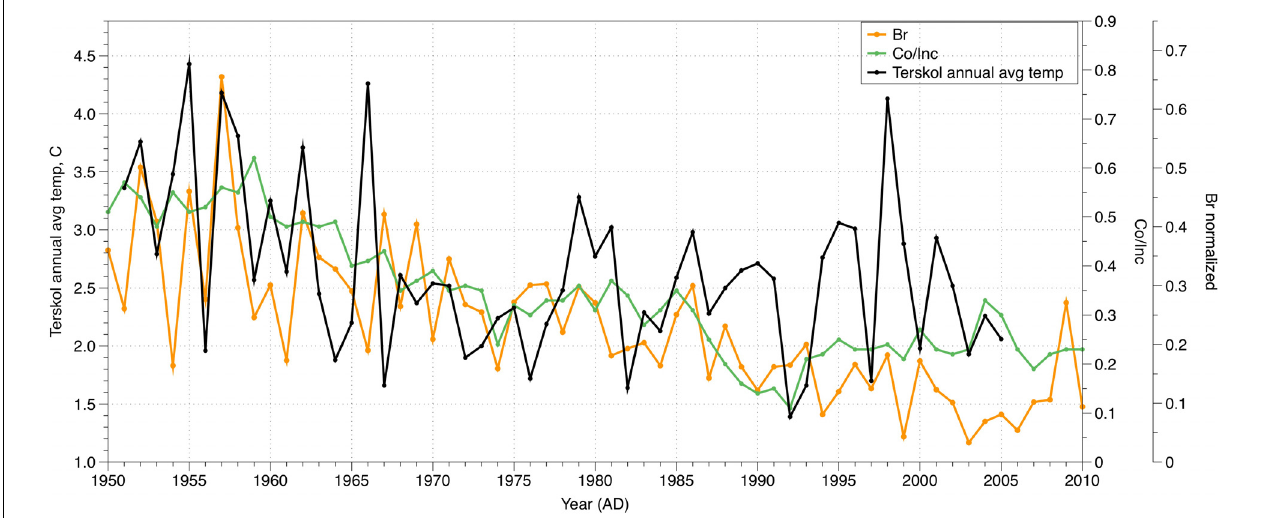
FIGURE 10 | Annual average temperature recorded at the Terskol meteorological station compared with the yearly maximal values of bromine and Co/Inc ratio.